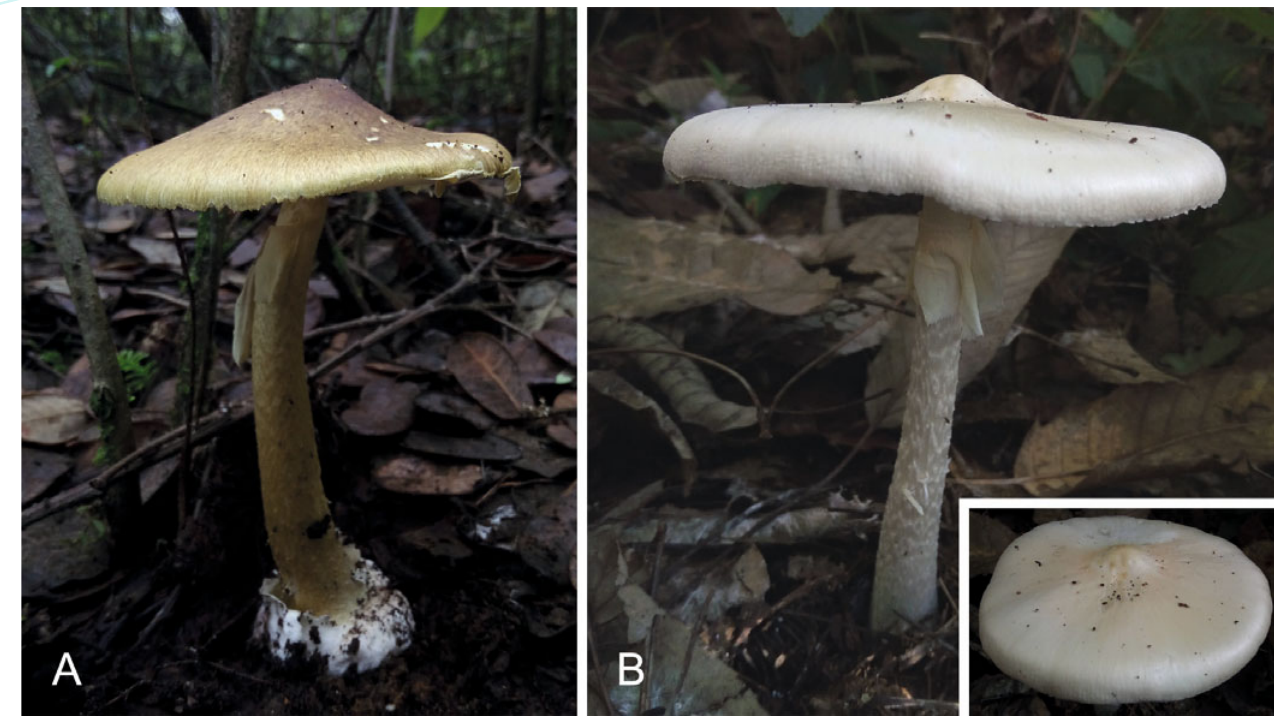
Fig. 1. Deadly Amanita subjunquillea and A. pallidorosea (cid:19)(cid:4)(cid:23)(cid:23)(cid:13)(cid:19)(cid:8)(cid:13)(cid:21)(cid:2)(cid:11)(cid:17)(cid:2)V(cid:14)(cid:11)(cid:17)(cid:9)(cid:2)(cid:26)(cid:4)(cid:10)(cid:2)(cid:25)(cid:13)(cid:17)(cid:4)(cid:6)(cid:13)(cid:2)(cid:7)(cid:13)}(cid:5)(cid:13)(cid:17)(cid:19)(cid:11)(cid:17)(cid:25)[(cid:2) A. A. subjunquillea (cid:24)1_$F(cid:2)U9U(cid:31)*(cid:27)(cid:28)(cid:2) B. A. pallidorosea